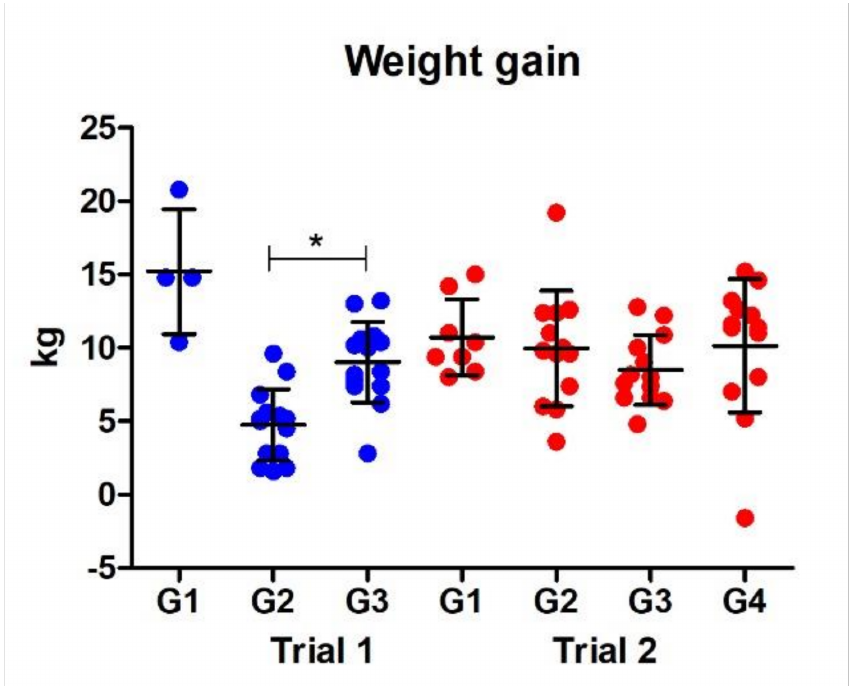
Figure 4. Graphical representation of the total weight gain during the vaccine trial. The weight gain for each animal was calculated as the difference between the final weight at necropsy and the starting weight at the beginning of the trial. Statistical difference between the control group (G2) and vaccinated group (G3) for Trial 1 is highlighted (* p < 0.05). G1, control unvaccinated, uninfected; G2, control unvaccinated, infected; G3 and G4, vaccinated,